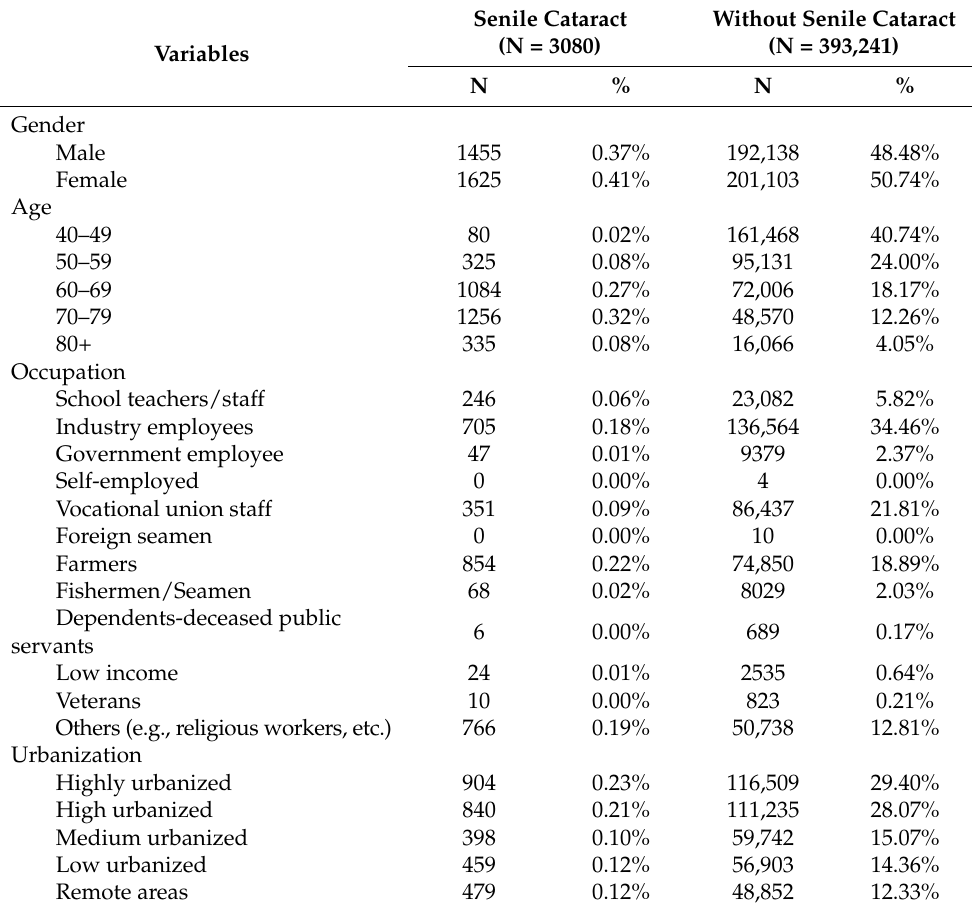
Table 2. Descriptive Analysis (N =